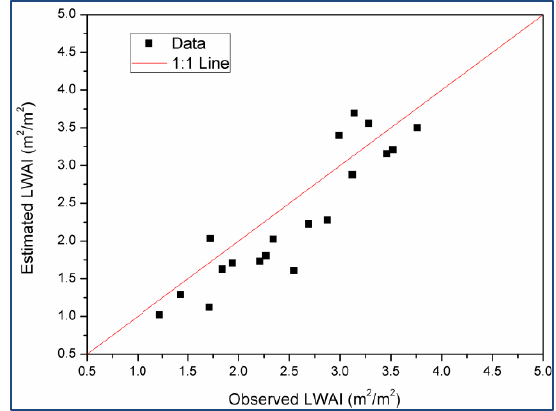
Figure 5.Comparison between observed and estimated values of LWAI by modified WCM